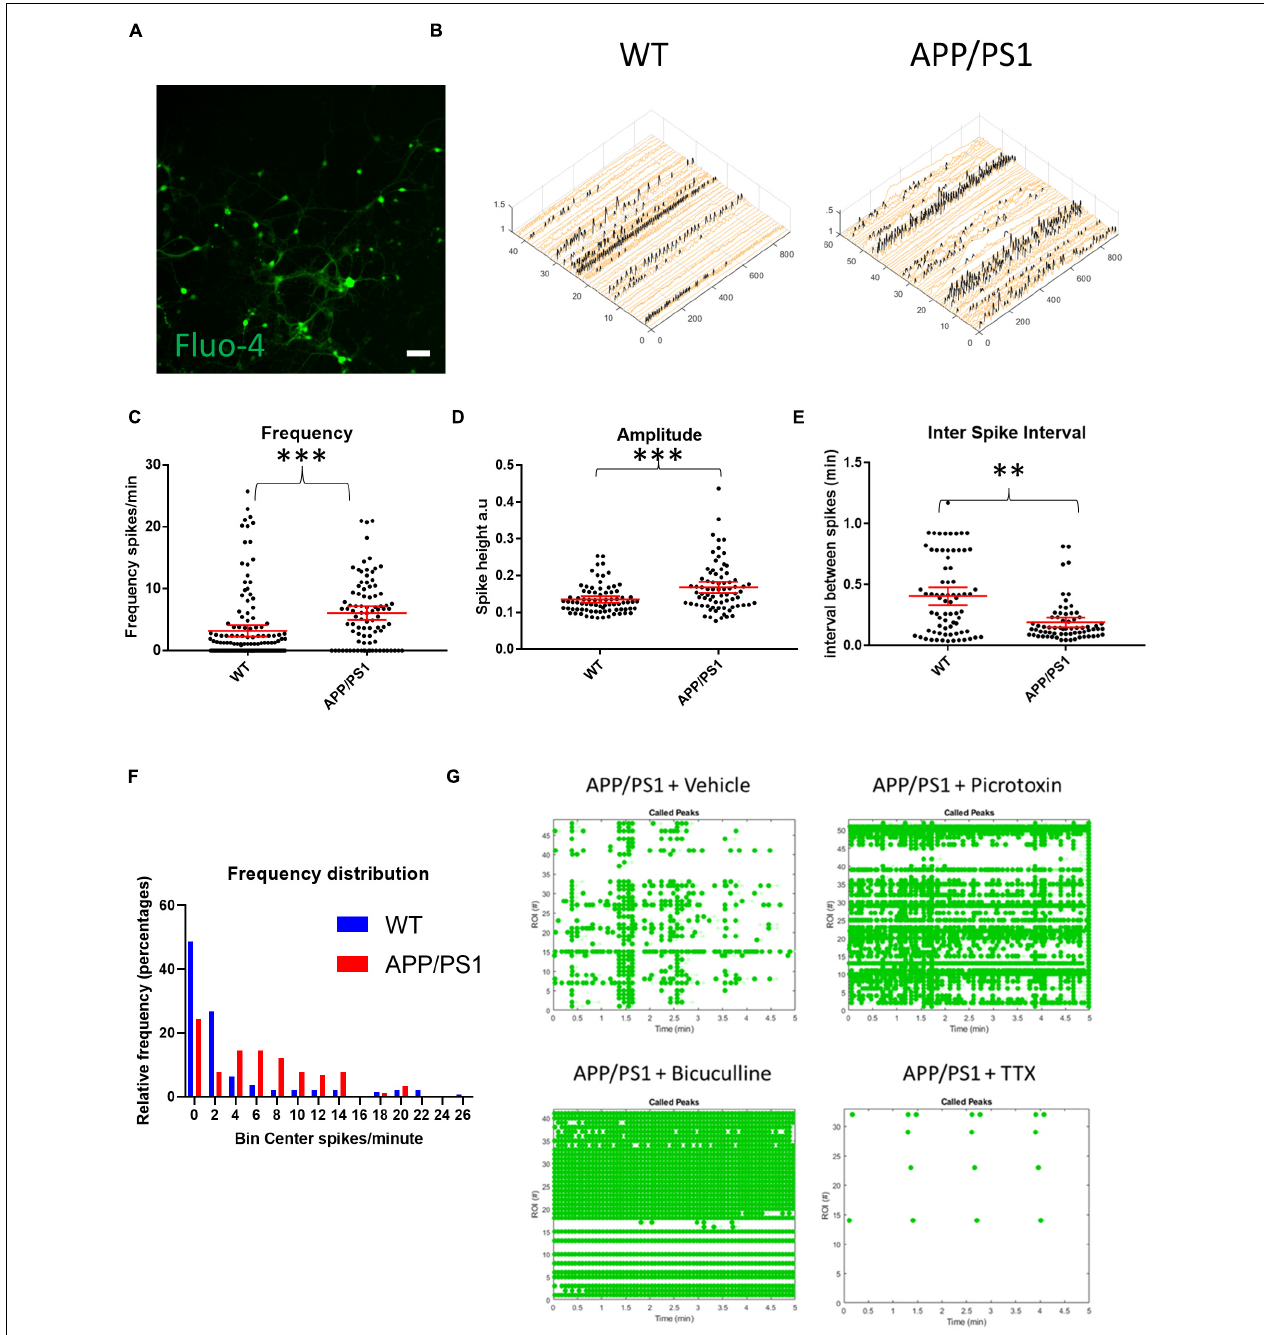
FIGURE 1 | Increased spontaneous activity in APP/PS1 primary neurons. (A) Representative micrograph of cultured neurons loaded with Fluo4. (B) Representative calcium traces from WT and APP/PS1 field of views (FOVs), black spikes are recognized by the Peakcaller algorithm. X -axis shows region of interest (ROI) number, Y -axis shows amplitude and Z -axis shows time point. (C) Frequency of firing (spikes per minute) is increased in APP/PS1 compared to WT neurons (APP/PS1 mean = 6.072, CI = 4.948–7.197, n = 90 compared to WT mean = 3.184, CI = 2.25–4.118, n = 142, p < 0.0001). (D) Amplitudes of spikes are increased in APP/PS1 compared to WT neurons (APP/PS1 mean = 0.1682, CI = 0.1532–0.1833, n = 76, compared to WT mean = 0.1352, CI = 0.1266–0.1437, n = 80, p = 0.0003). (E) Inter-spike interval distributions differ between APP/PS1 compared to WT neurons with more of the APP/PS1 neurons having low inter-spike intervals ( p = 0.0011 using Kolmogorov–Smirnoff test). (F) Frequency distribution of firing frequencies of APP/PS1 compared to WT neurons shown in a graph; note higher percentage of WT neurons in the inactive bins; WT inactive = 69, APP/PS1 inactive = 22, WT active = 73 and APP/PS1 active 68, p = 0.0003, Fisher’s exact test; N = 4 cultures. (G) Representative Raster plot of APP/PS1 neurons treated with vehicle (sterile milliQ water), 10 µ M of picrotoxin, 20 µ M of bicuculline or 1 µ M of tetrodotoxin (TTX); neurons were imaged every 100 ms for 5 min with detected spikes represented as green dots. Mann–Whitney U test; ∗∗ p < 0.01, ∗∗∗ p < 0.001; scale bar: 50 µ